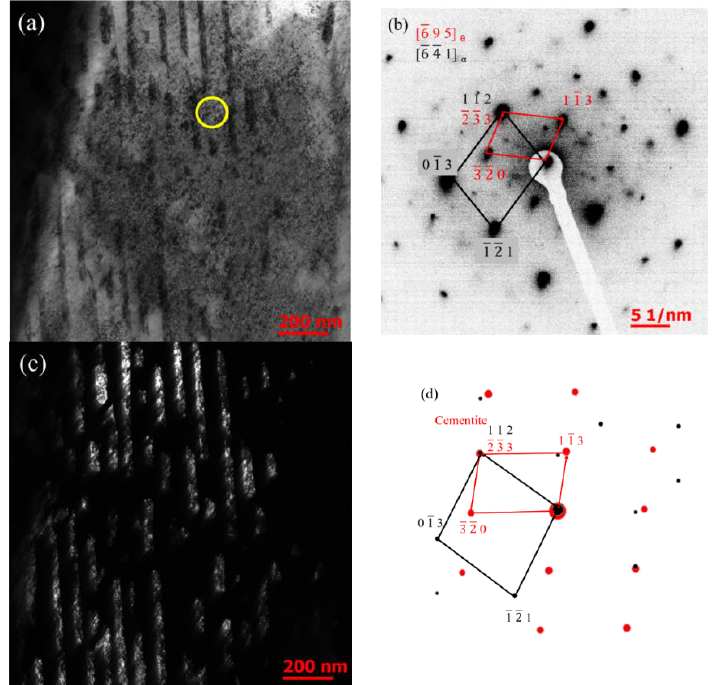
Figure 9. The ( a ) BF image of the interface WEL-TEM specimen; ( b ) SAD pattern and ( d ) indexed pattern of the region enclosed in the circle shown in ( a ). The DF image in ( c ) is obtained from the ( ) 211 reflection of cementite.